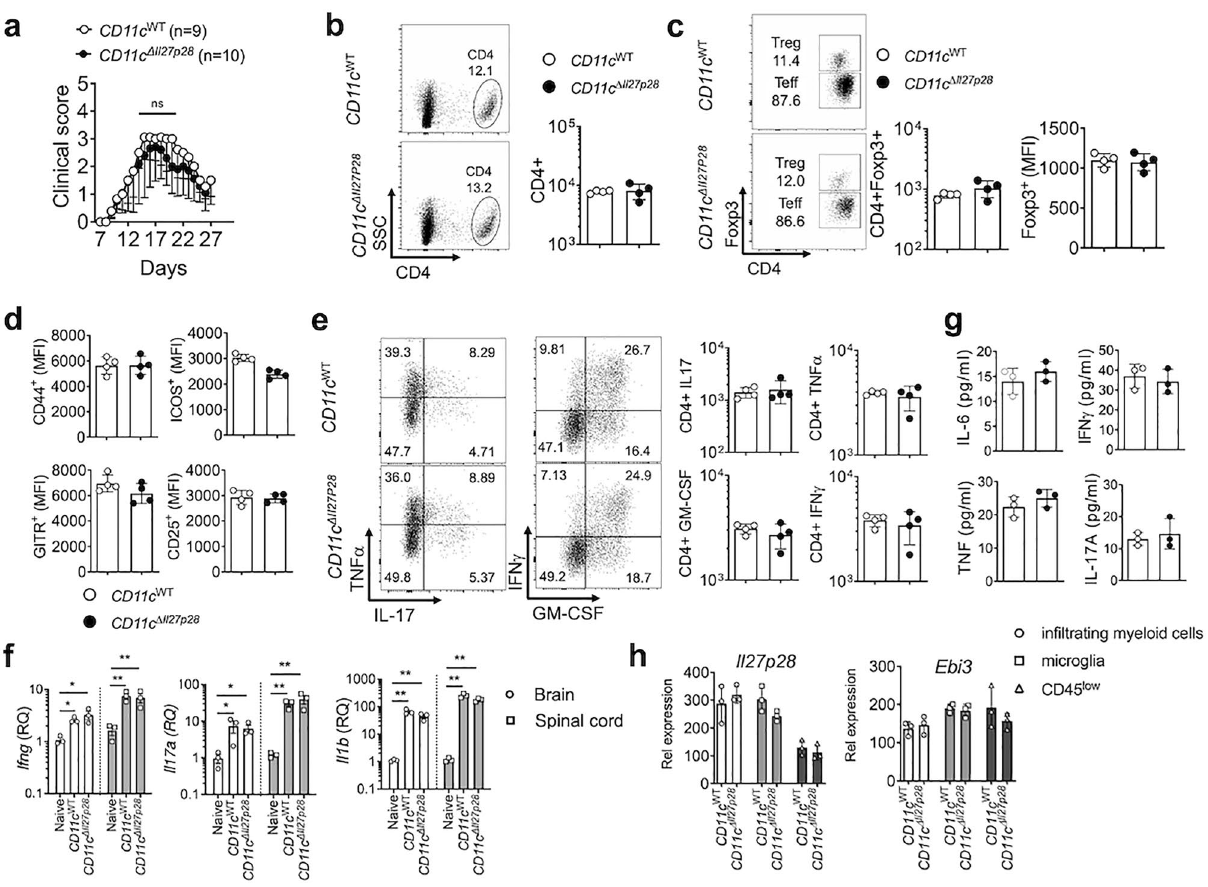
Figure 3. EAE in DC-specific Il27p28 −/− mice. CD11c WT (n = 9) and CD11c Cre Il27p28 fl/fl (CD11c ΔIl27p28 ) (n = 10) were induced for EAE. ( a ) Time course of the development of EAE. ( b – d ) The numbers of CNS-infiltrating CD4 + and CD4 + Foxp3 + Treg cells, and the mean fluorescence intensity (MFI) of Foxp3, CD44, ICOS, GITR and CD25 were determined by flow cytometry at day 17 post immunization. ( e ) Flow cytometry analysis of GM-CSF, IFN-γ, IL-17, and TNFα CD4 + T cells from the CNS of EAE mice (day 17 post immunization). ( f ) RNAs isolated from the brain and spinal cords at day 17 post immunization were analyzed for the expression of Ifng, Il17a, and Il1b . n = 3 per group. Gene expression was normalized by Gapdh and compared to that of naïve mice. ( g ) The levels of IL-2, IL-4, IL-6, IFNg, TNFa and IL-17A in the serum of EAE mice (day 17 post immunization) were measured using the Cytometric Bead Array. Each serum sample was analyzed in duplicates. ( h ) qPCR analysis of the indicated mRNAs in freshly sorted CD45 high CD11b high (infiltrating myeloid cells), CD45 int CD11b high (microglia) and CD45 low (astrocyte and oligodendrocyte) cells from CD11c WT and CD11c ΔIl27p28 mice with EAE. *p < 0.05; **p < 0.01; ***p < 0.001; as determined by Mann–Whitney nonparametric